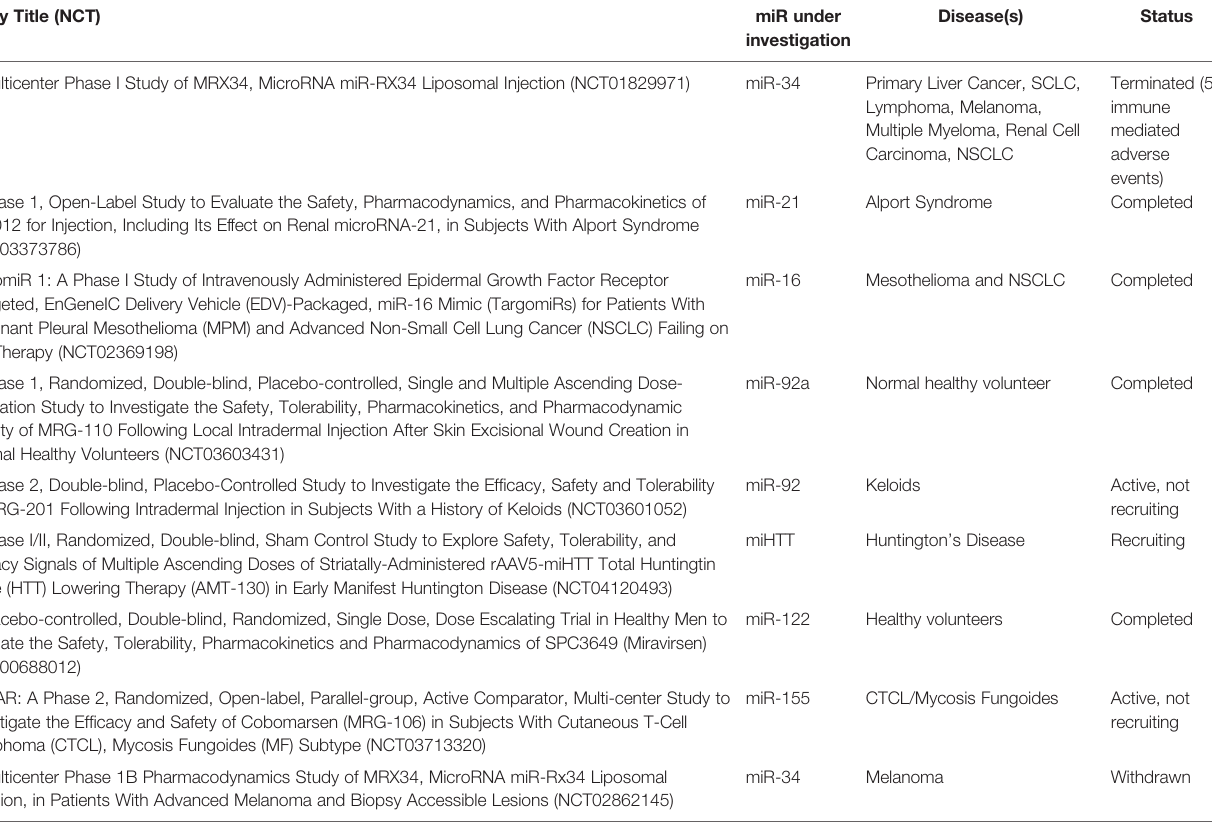
TABLE 2 | MicroRNA-directed clinical